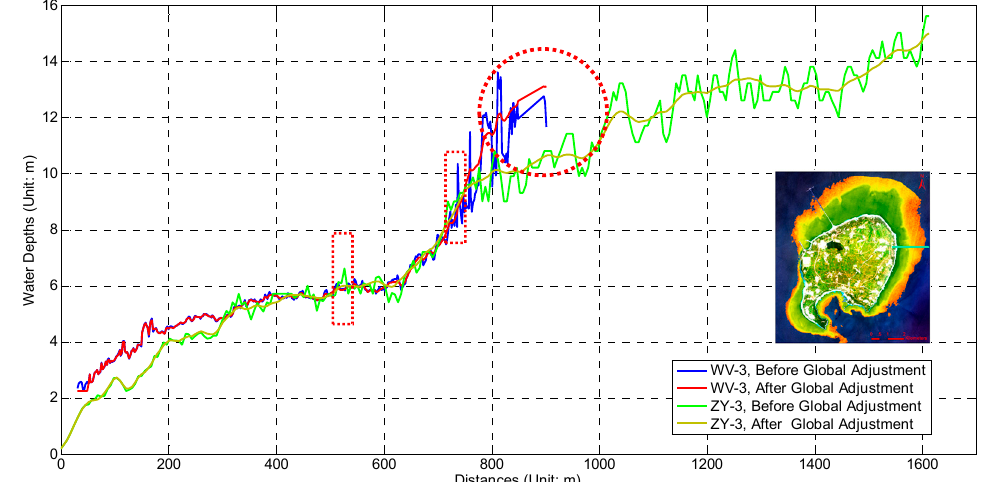
Figure 13. The water depths along a transect of the two images: the dotted boxes mark some possible large outliers of the water depths of the ZY-3 or the WV-3 image before the global adjustment; the dotted circle marks the place where the local variations and the differences of the water depths estimated from the two images become large.